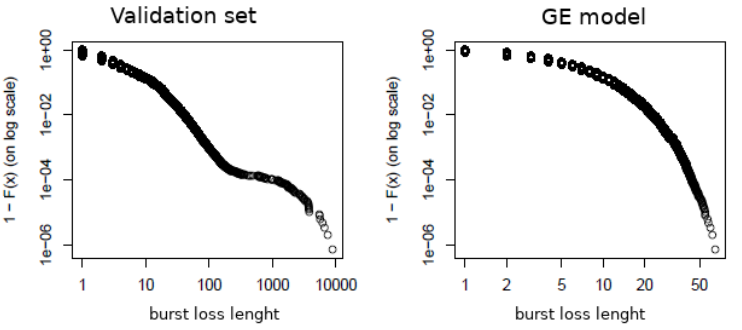
Figure 10. LLCD of BLL for the validation set and the GE